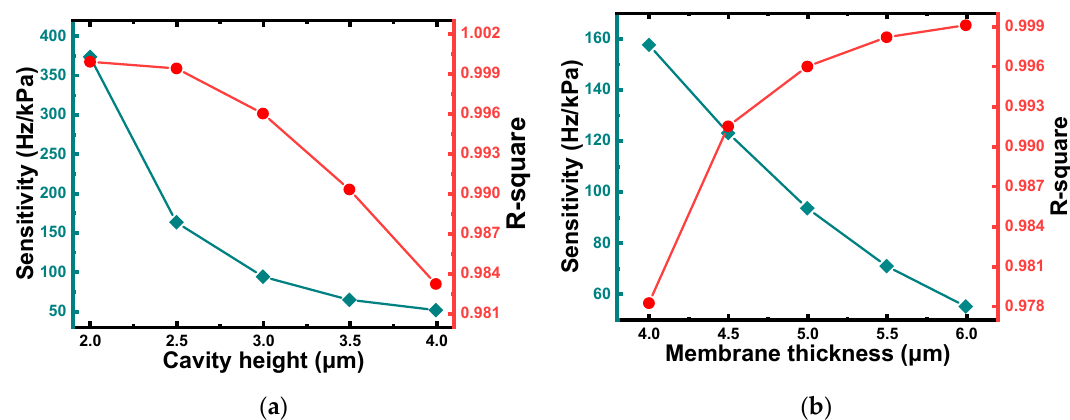
Figure 5. ( a ) Pressure sensitivity and linear fit of C1 with cavity heights of 2 μm , 2.5 μm , 3 μm , 3.5 μm , and 4 μm and membrane thickness of 5 μm under pressures of 0–10 kPa. ( b ) Pressure sensitivity and linear fit of C1 with membrane thicknesses of 4 μm , 4.5 μm , 5 μm , 5.5 μm , and 6 μm and cavity height of 5 μm under pressures of 0–10 kPa.